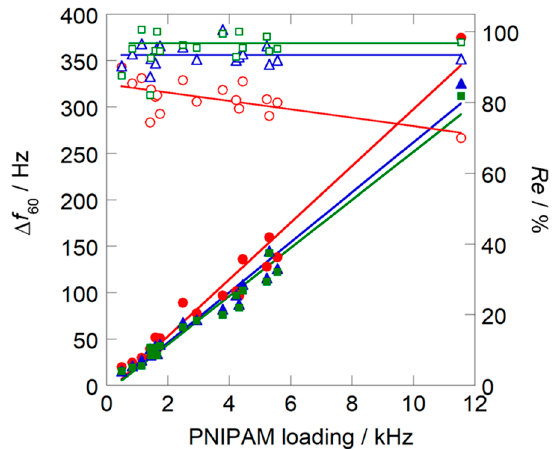
Figure 8. Dependence of the magnitude of the sensor response and recovery on PNIPAM loadings measured at 30 °C: ( ● ) first cycle; ( ▲ ) second cycle; ( ■ ) third cycle. Closed symbols show the sensor response; open symbols indicate the recovery.